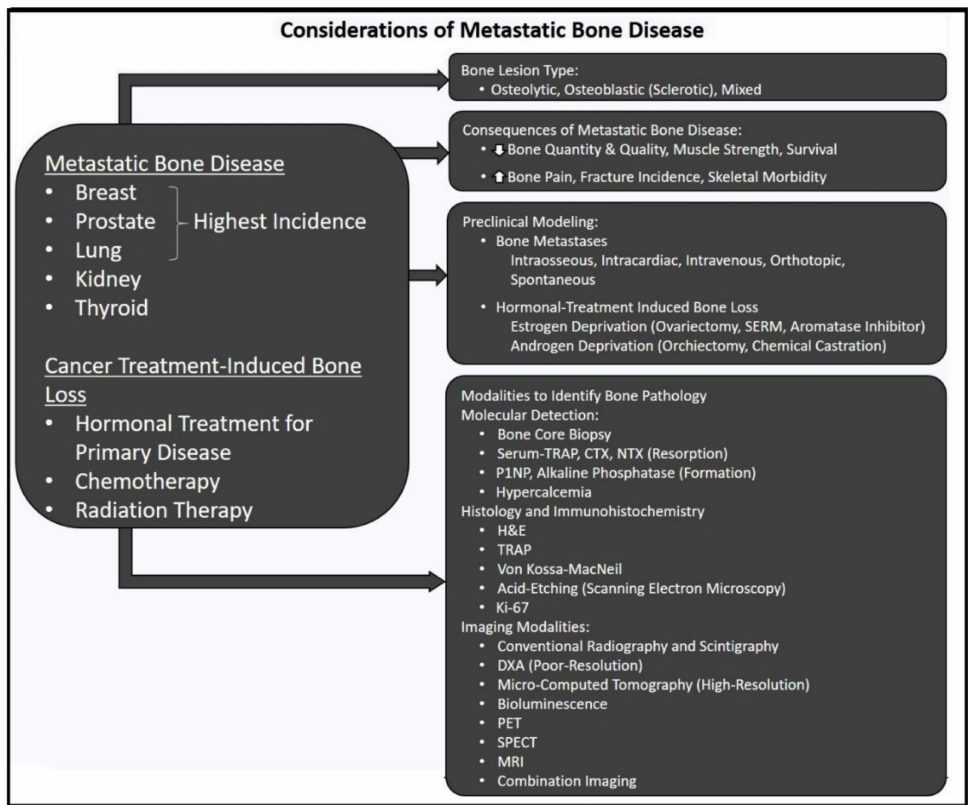
Figure 1. Metastatic bone disease and the various treatment strategies employed to combat tumor progression corrupt the bone remodeling pathway. Incidence and lesion type vary depending on the phenotype of the primary malignancy and can even vary amongst subtypes within bone metas- tases. Treatments can directly target bone matrix (irradiation) or indirectly (hormone deprivation, chemotherapy) by interrupting pathways critical to maintaining normal bone remodeling and healthy musculoskeletal tissue. Systems modeling metastatic bone disease can be achieved by introducing murine and human cell lines intravenously, left ventricular intracardiac inoculation, intraosseous injection into tibiae or femora, orthotopically or using spontaneous models (predominantly